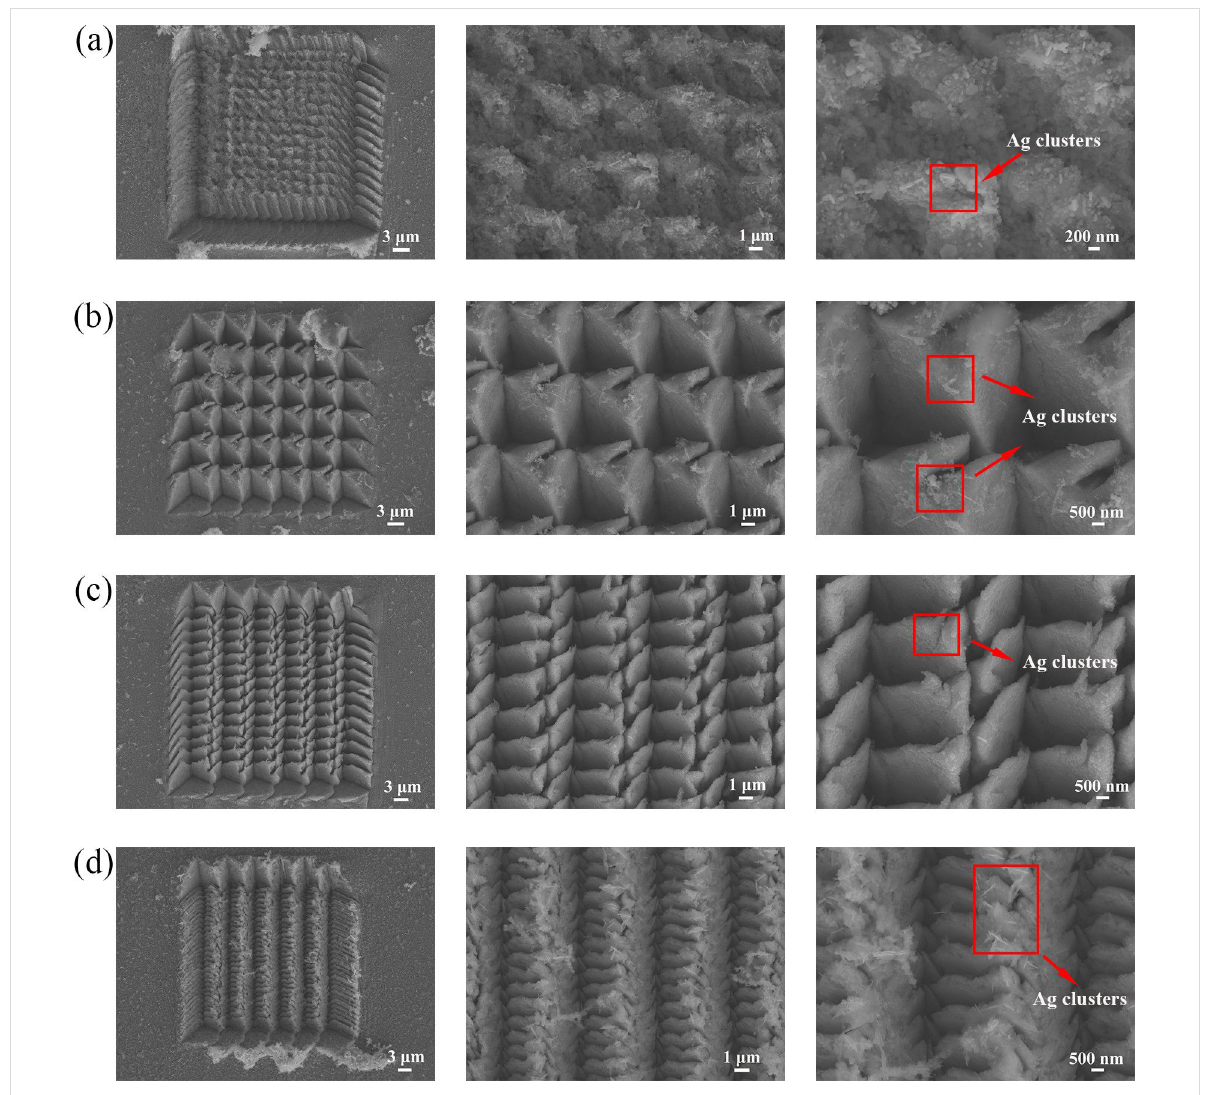
Figure 2: SEM images of the arrayed triangular cavities with different feeds in AgNO 3 solution for 10 minutes: (a) f x = 2 μ m, f y = 2 μ m, (b) f x = 5 μ m, f